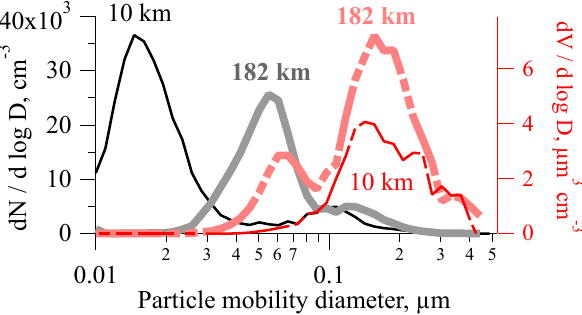
Figure 11. SMPS number and volume size distributions obtained 10 and 180km from the